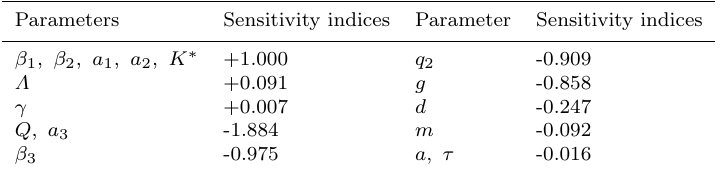
Table 2. Sensitivity indices of parameters.